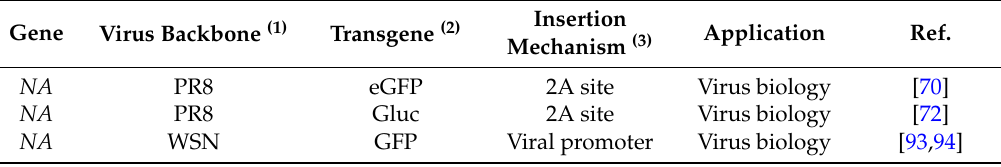
Table 5. NA recombinant reporter-expressing influenza A